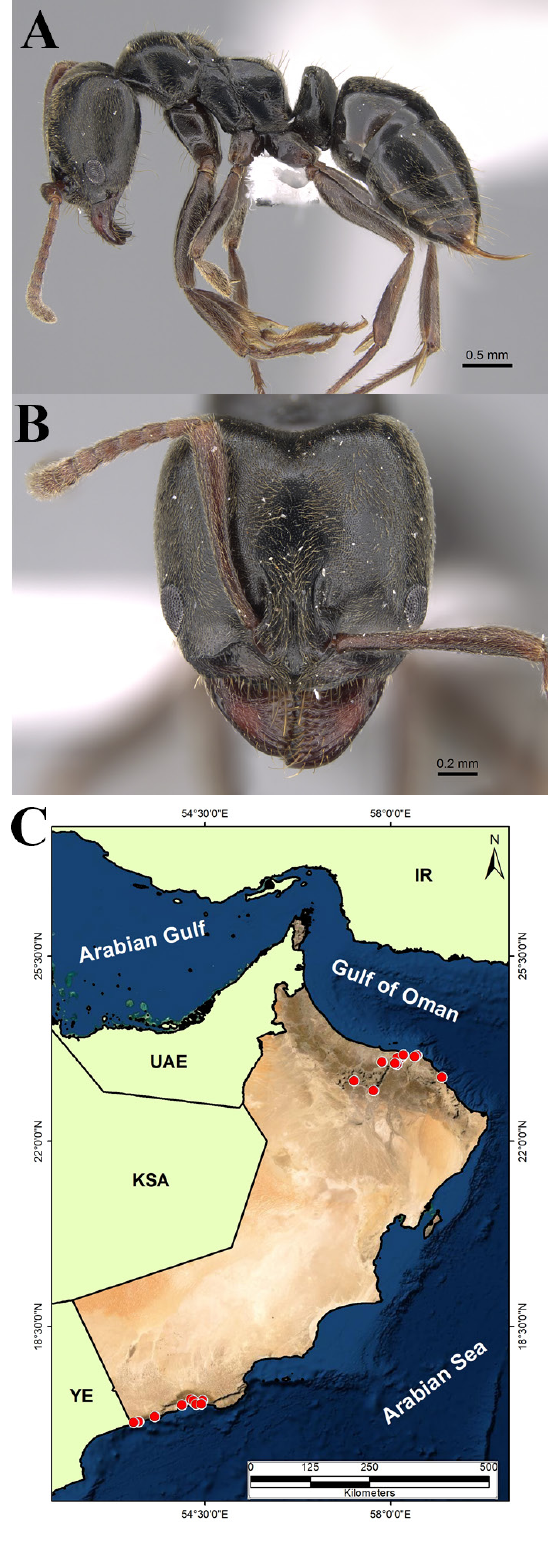
Fig. 53. Brachyponera sennaarensis (Mayr, 1862), worker (CASENT0922868, AntWeb.org (Michele Esposito)). A . Body in profile. B . Head in full-face view. C . Distribution